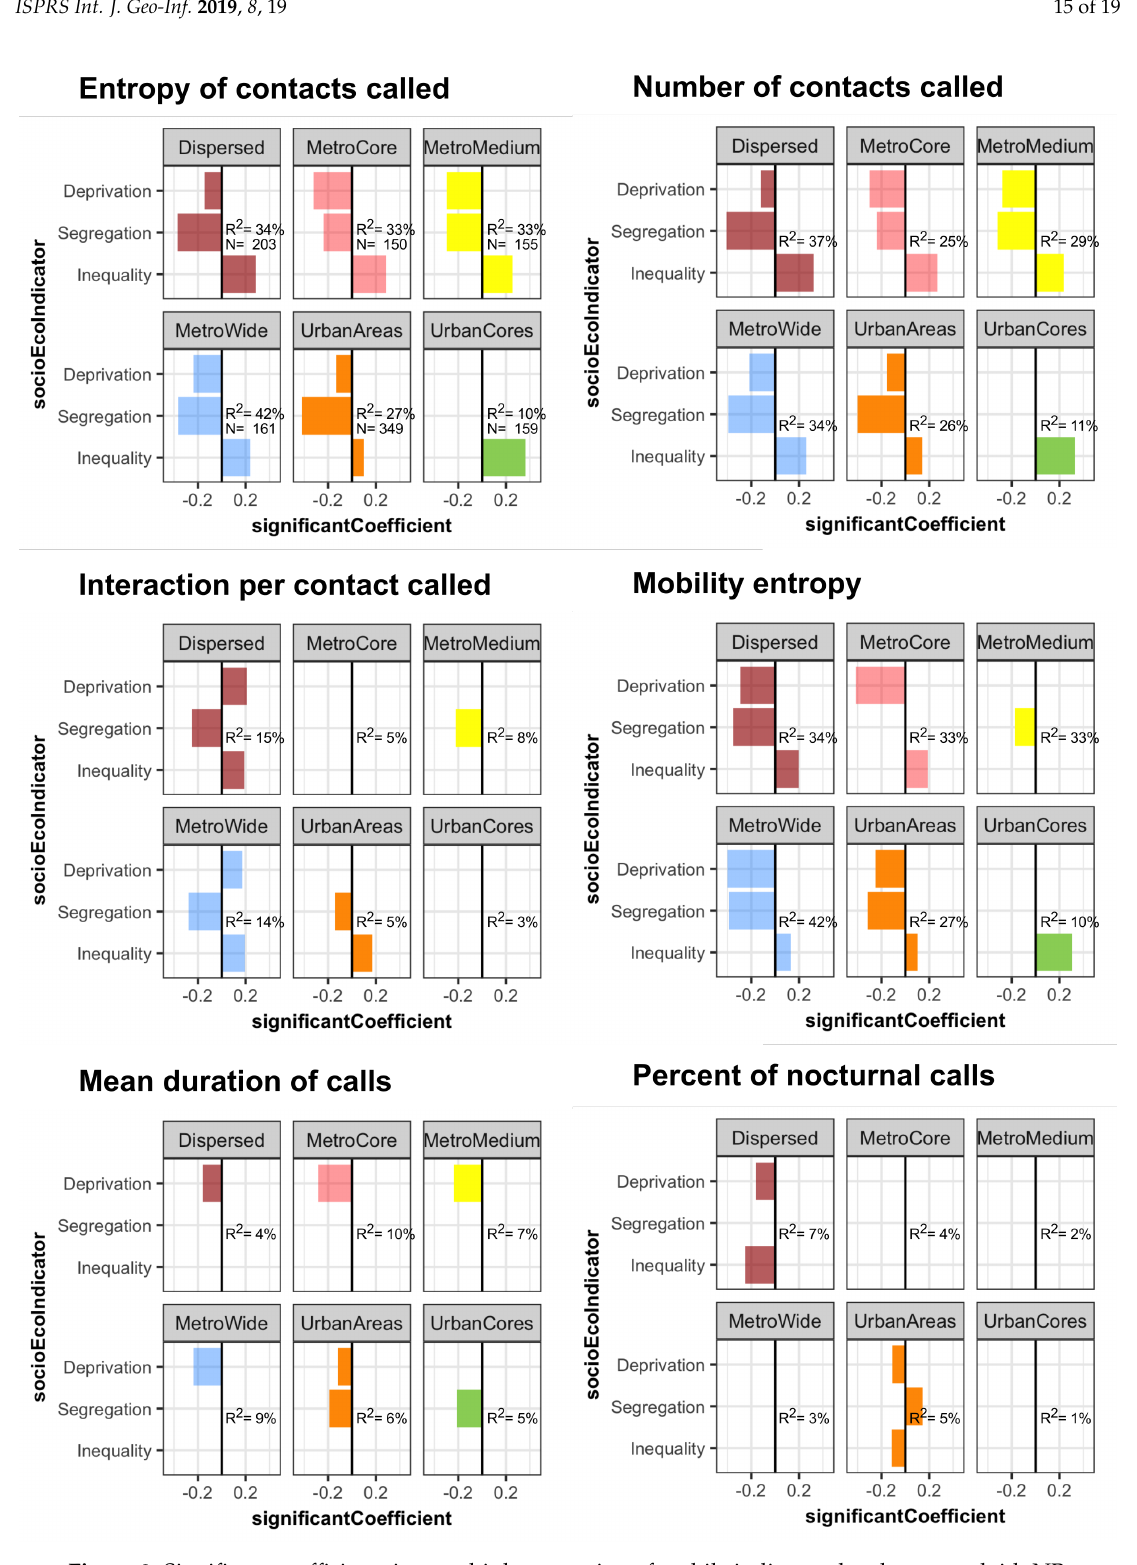
Figure 9. Significant coefficients in a multiple regression of mobile indicators by cluster medoid. NB: In this figure, the number of observation N refers to the number of clusters within the representative medoid definition. It is a number of cities which are included in the regression for a given